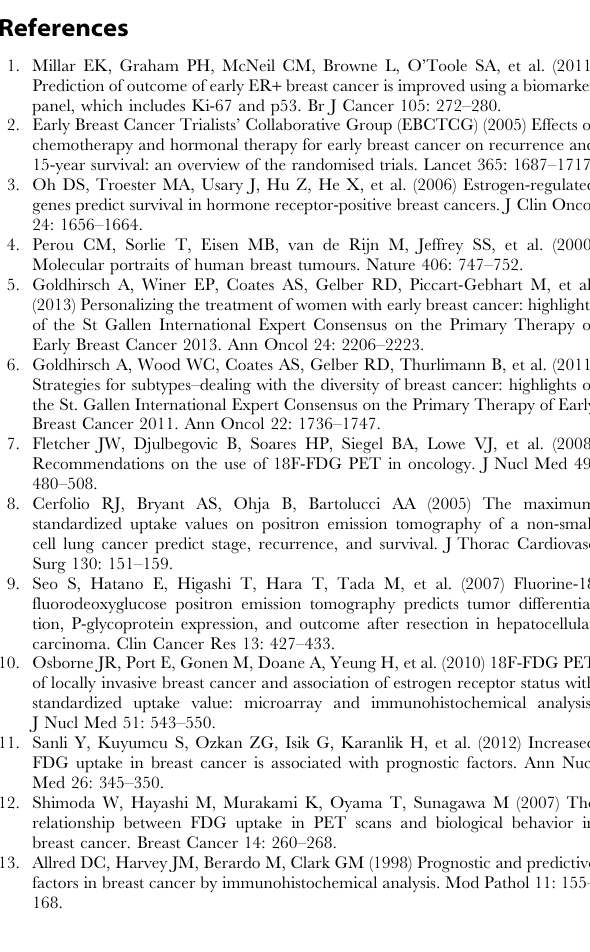
Table S2 Multivariate analysis using Cox regression hazard model for recurrence-free survival in patients receiving adjuvant chemotherapy (n